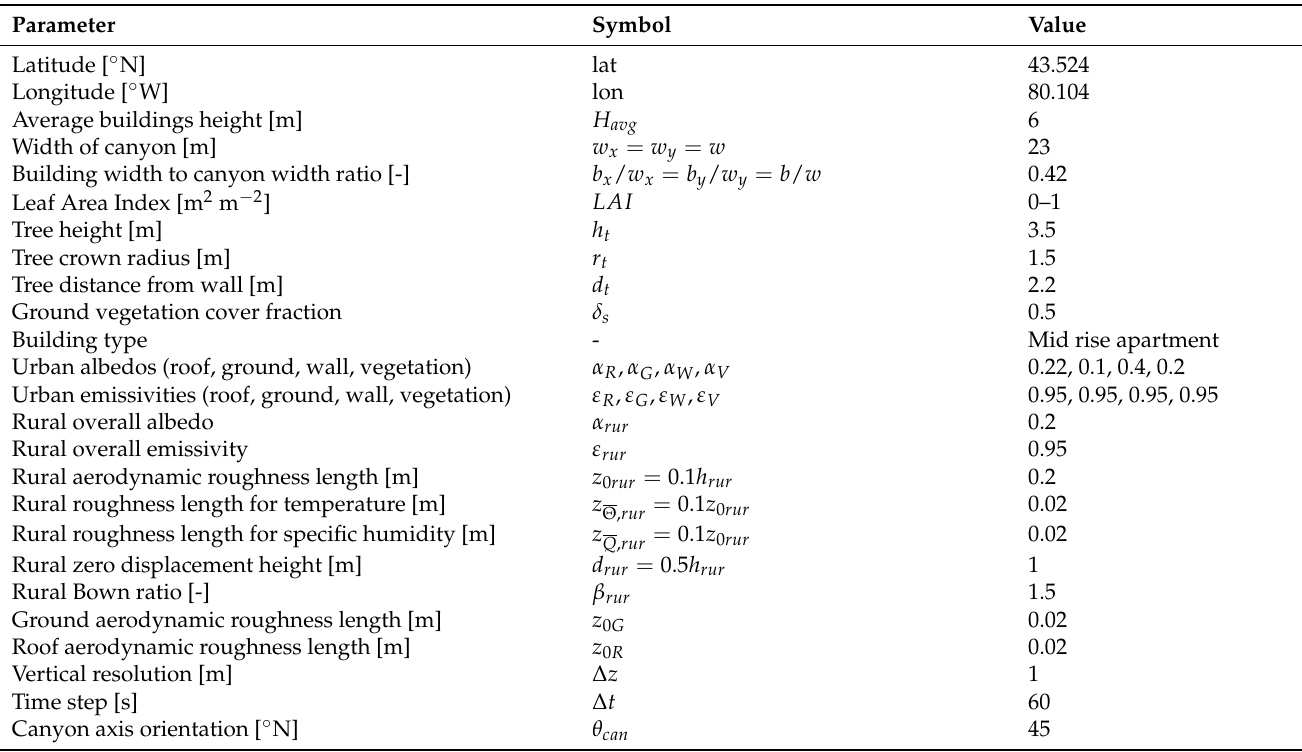
Table 1. List of input parameters used in